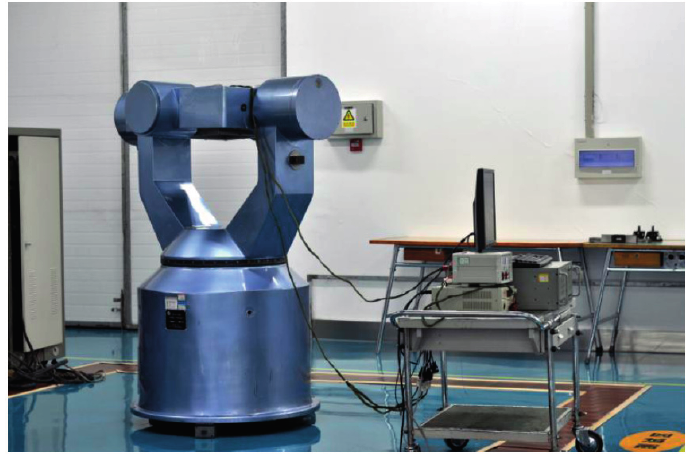
Figure 18. Picture of the whole experimental layout.